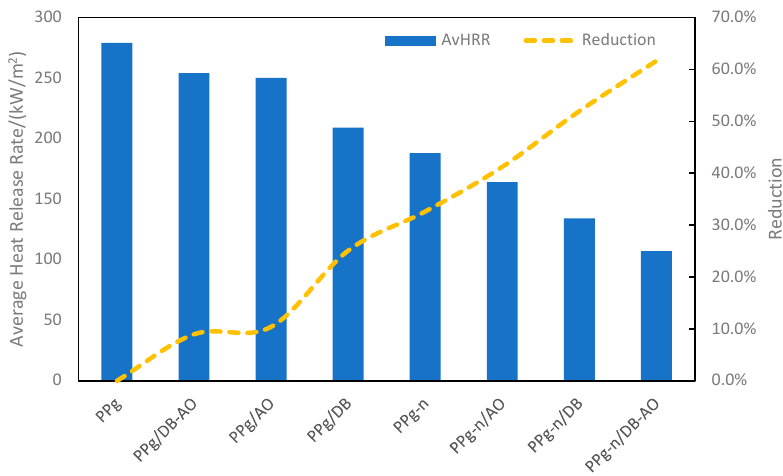
Figure 2. Average heat-release rate of flame-retardant polypropylene and reduction on HRR (PPg: polypropylene-graft-maleic anhydride, PPg-n: polypropylene with montmorillonite clay) [6].